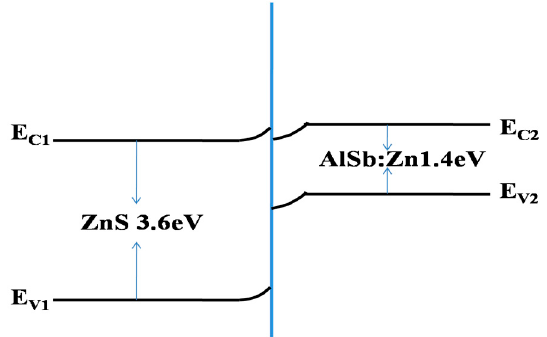
Figure 9. The energy band of the ZnS/AlSb:Zn heterojunction.